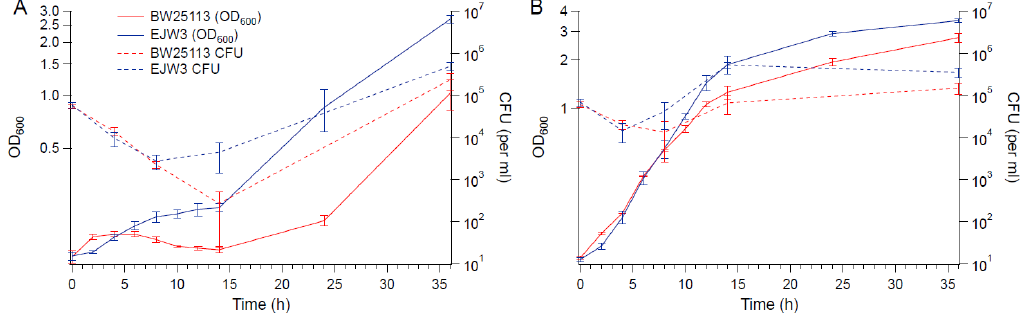
Figure 2. Growth and viability curves. ( A ) M9 with 0.6 M NaCl. ( B ) M9 with 0.6 M NaCl and tryptophan (50 µg mL −1 ). Error bars are standard deviations.